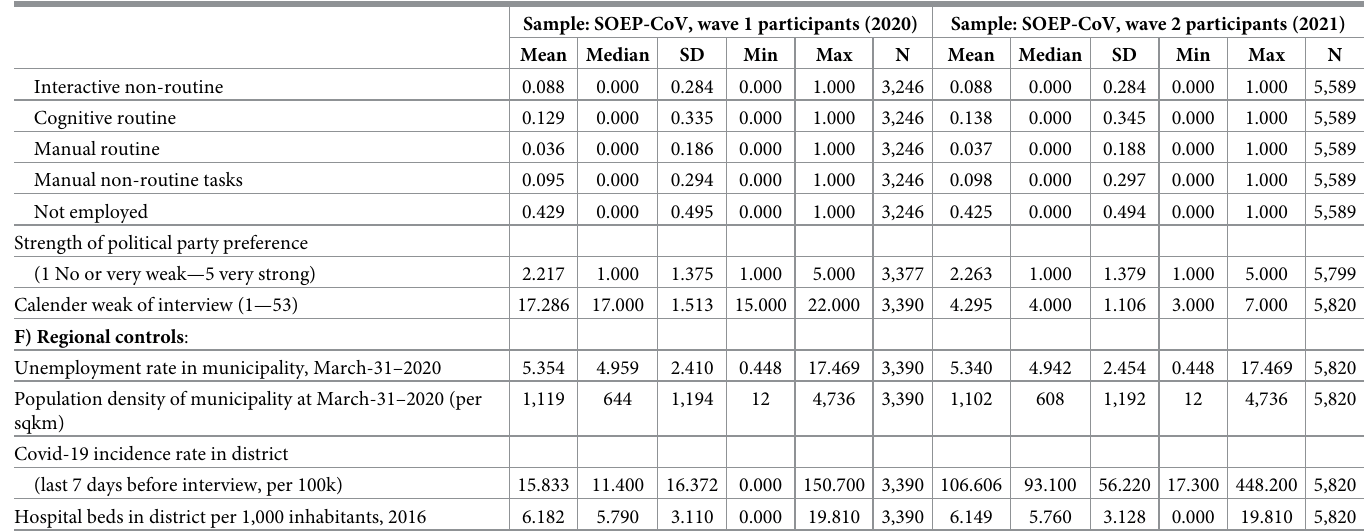
Fig 1 indicates the number of observations in our main sample per NUTS-2 region and maps mean values of our main dependent and independent variable across NUTS-2 regions (NUTS- 2 corresponds to a subdivision of the 16 federal states into 38 regions). Respondents in our sample are distributed over all NUTS-2 regions, with 43 in the region with the lowest number of responses (Mean: 242; Median: 183; SD: 137). In Table 2, we report the descriptive statistics on all utilized variables. Panel A) refers to our dependent variable compliance index . With 87 percent of measures followed in 2020 and 88 percent in 2021, compliance is stable on average over time. However, there are considerable variation across the items. For example, avoiding contact with people at particular risk and avoiding public transportation decreased by 7 and 6 percentage points, respectively. In contrast, the use of masks in everyday life has risen